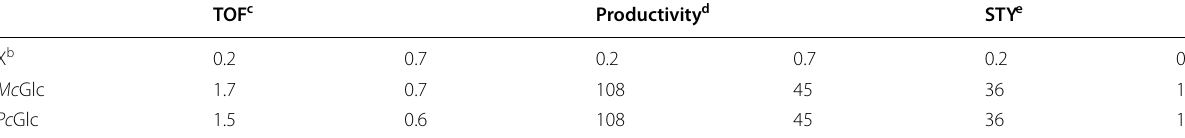
Table 4 Performance of Mc Glc and Pc Glc in hydrolysis reactions at low and high conversions with 2 in suspension